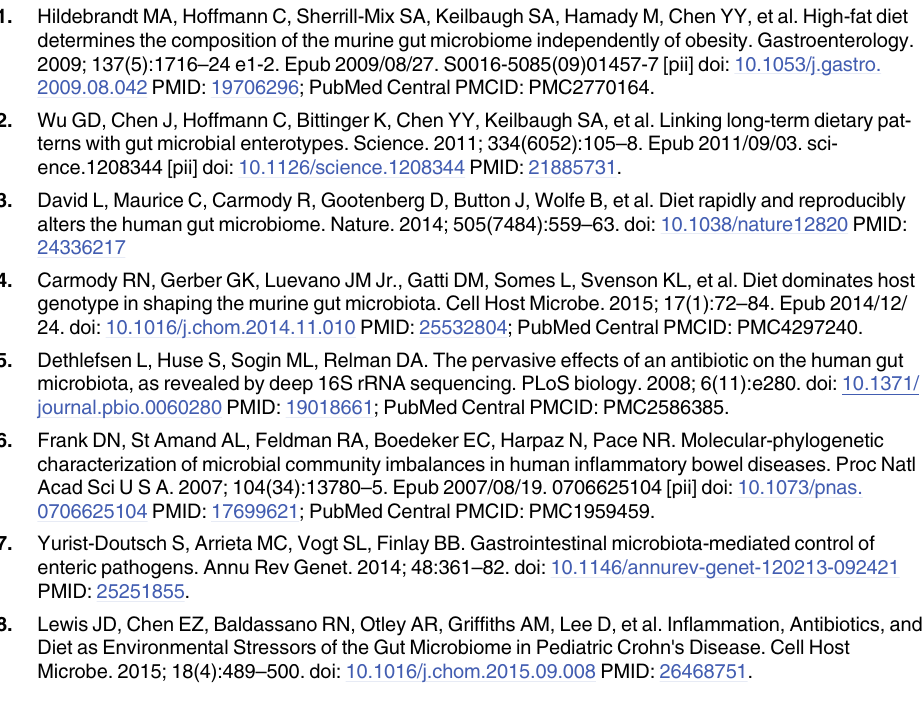
S3 Fig. Relative abundance of bacterial taxa after ASF transplantation. Each bar represents a single sample. Samples represent pre-treated ASF-inoculated mice on the NPD (NPD + ASF). Progression is shown across multiple days post-inoculation with ASF. S4 Fig. Murine mortality on a LPD. Kaplan Meier curve showing no significant difference in survival between ASF- and NF-transplanted mice on the LPD (n = 5 per group at start of experiment). S1 Table. ASF consortium membership. ASF consortium number designation is indicated in the left column, and bacterial taxonomy at the genus or species level is indicated in the right